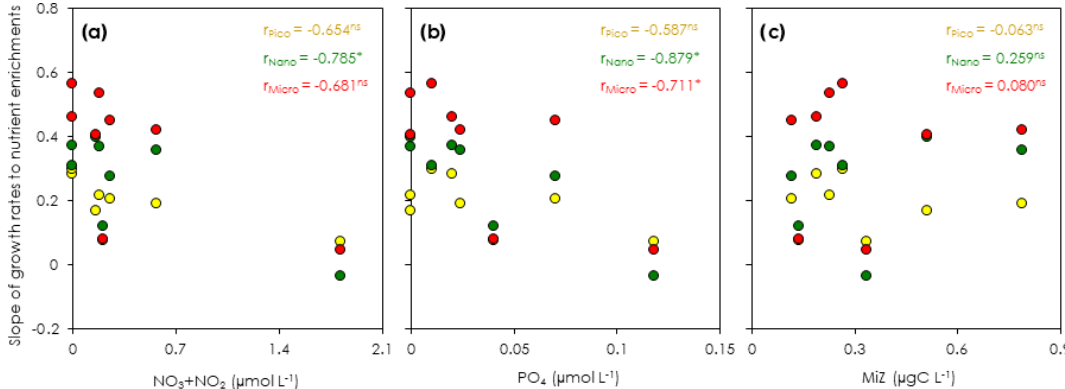
Figure 5. Correlation of the regression slopes of phytoplankton growth rates to nutrient concentrations and microsized heterotroph biomass at the beginning of the gradient-enrichment experiments (EXP a ). (a) Regression slopes of the size-fractionated phytoplankton growth versus the concentrations of nitrate (NO 3 ) plus nitrite (NO 2 ). (b) Regression slopes of the size-fractionated phytoplankton growth versus the phosphate concentrations (PO 4 ). (c) Regression slopes of the size-fractionated phytoplankton growth versus the microheterotroph biomass (MiZ). r : Pearson correlation coefficient. Pico: chlorophyll smaller than 2µm. Nano: chlorophyll between 2 and 11µm. Micro: chlorophyll larger than 11µm. ∗ : p <0.05. ns: not significant.